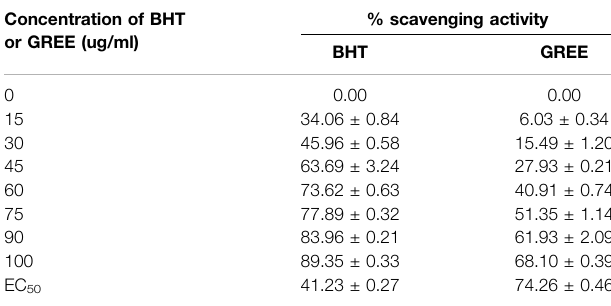
Adose-dependenteffectofDPPHscavenging(%)ofGREE(µgequivalentofthephenolic content) and comparison with BHT as the standard. EC 50 is the effective dose, which scavenges 50% of the DPPH radicals. The highlighted gray ones are the values close to the EC 50 values. The results are represented as mean ± SD of the assay in triplicate.